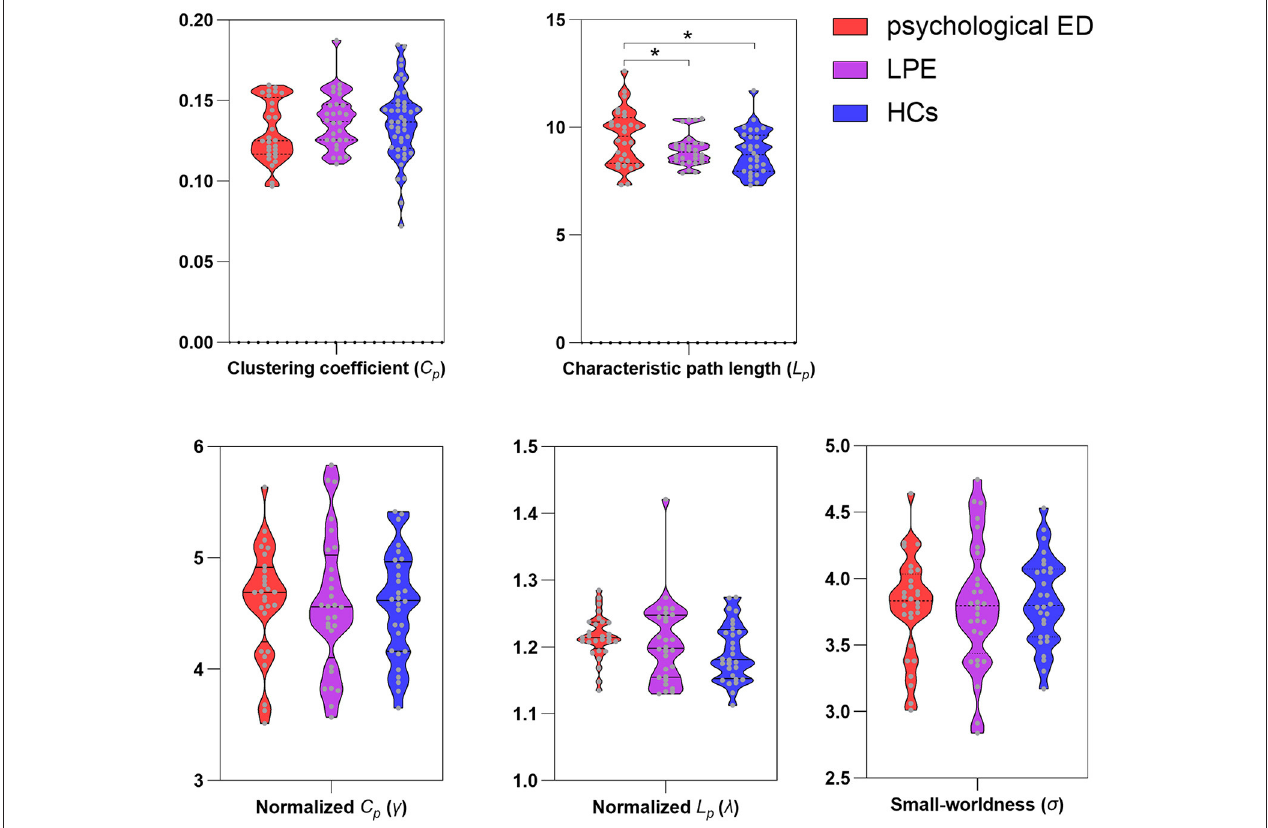
FIGURE 1 | Differences of small-world measures among three groups. ED, erectile dysfunction; LPE, lifelong premature ejaculation; HCs, healthy controls. *Significant differences between two groups detected by two-sample t -test. P < 0.05 was considered as statistically significant.